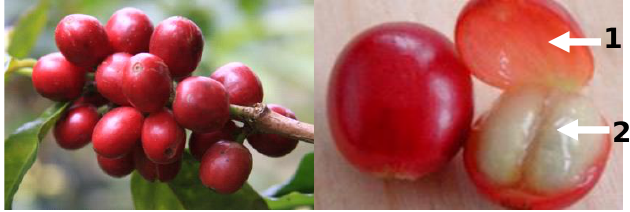
Figure 1. Appearance and structure of the ripe coffee cherries. 1. Pulp; 2. Bean coated by mucilage (outer pectin layer) and parchment coat (inner layer).